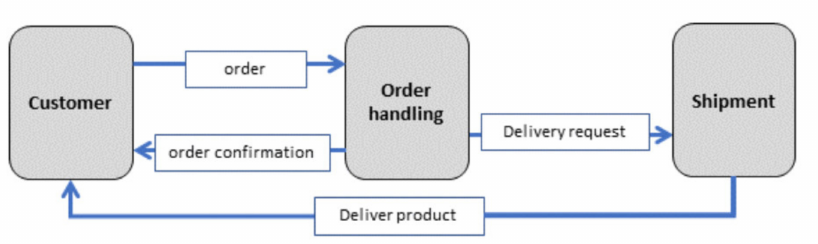
Figure 5. Subject Interaction Diagram for Order Handling, including subjects and messages.